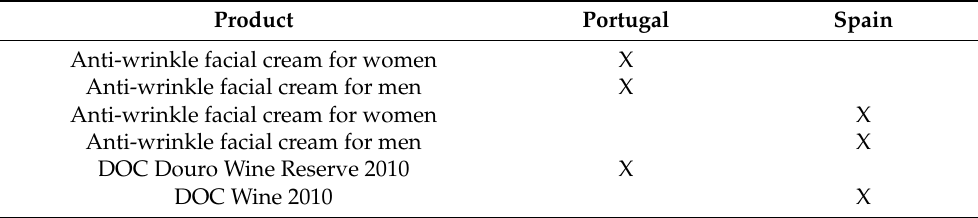
Table 1. Products by Markets. Product Portugal Spain Anti-wrinkle facial cream for women X Anti-wrinkle facial cream for men X Anti-wrinkle facial cream for women X Anti-wrinkle facial cream for men X DOC Douro Wine Reserve 2010 X DOC Wine 2010 X